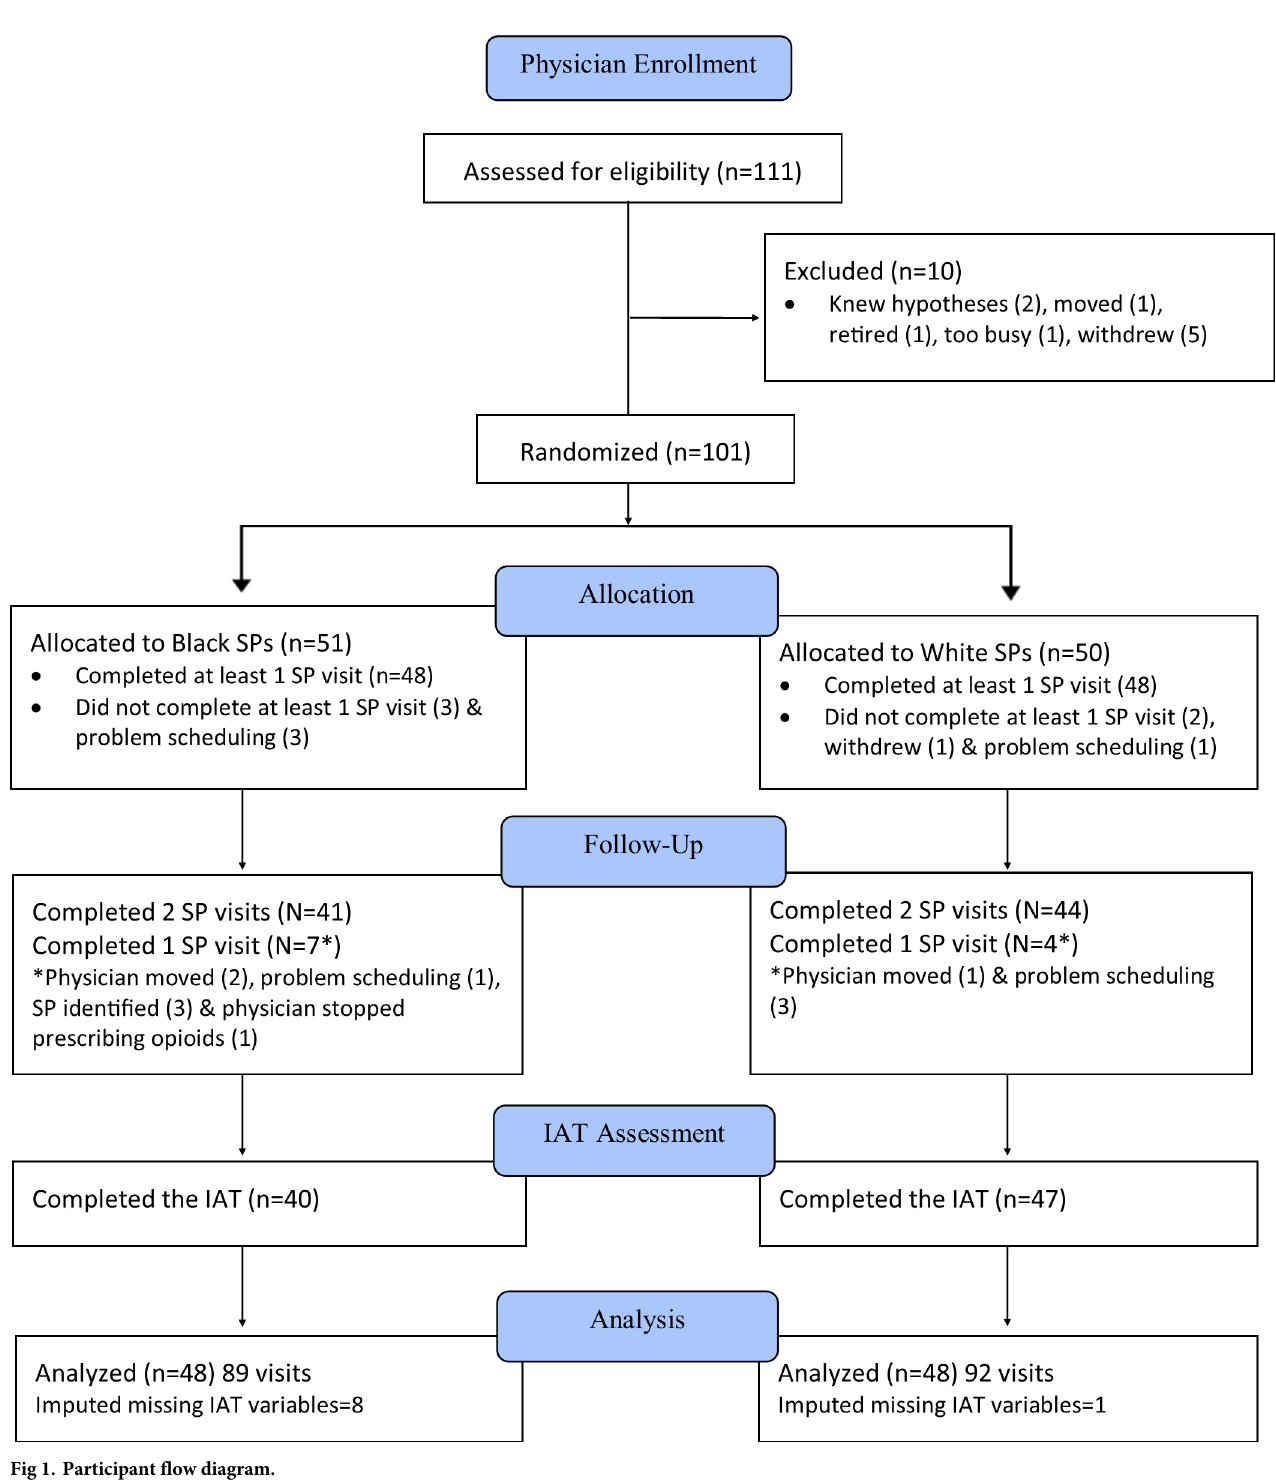
Fig 1. Participant flow diagram.